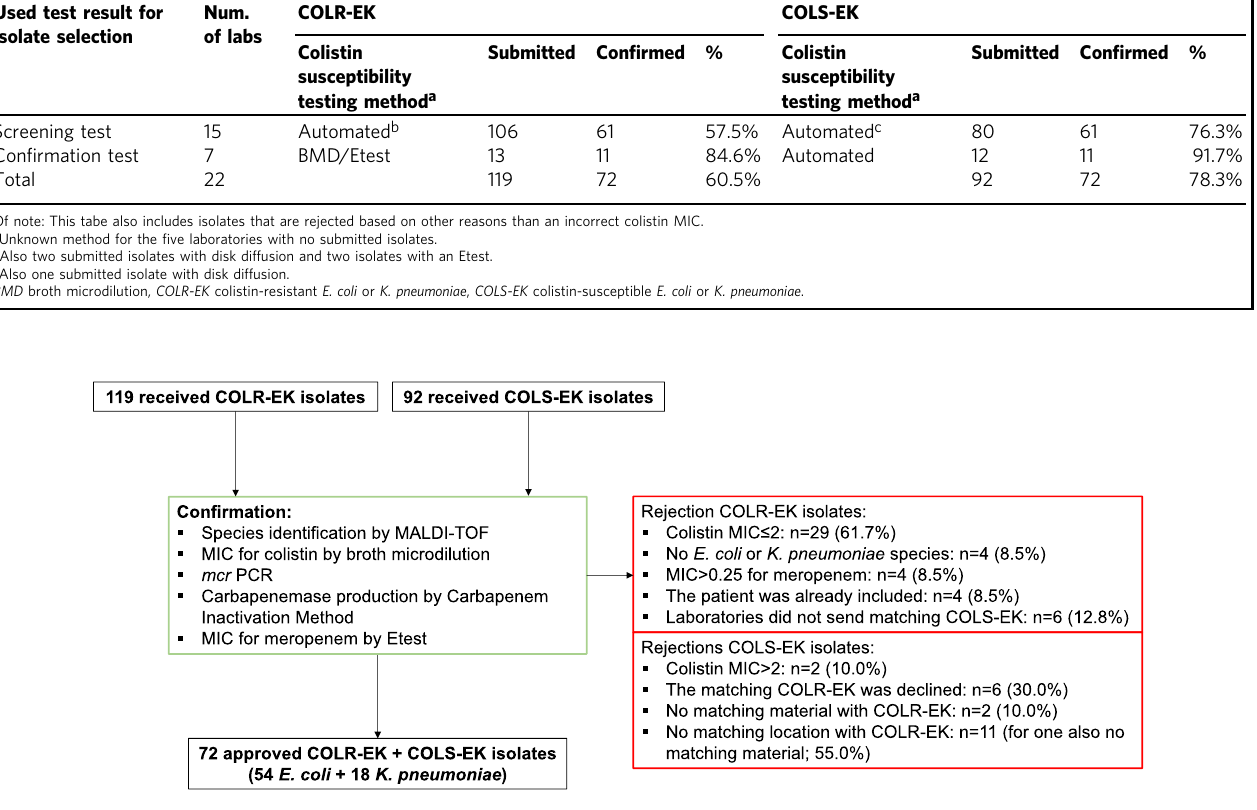
Fig. 1 Flow chart of received colistin-resistant and colistin-susceptible isolates. Methods used to decide which isolates met study inclusion criteria are denoted in the green square. Reasons for rejection of isolates for inclusion in the study are denoted in the red squares. COLR-EK: colistin-resistant E. coli or K. pneumoniae , COLS-EK: colistin-susceptible E. coli or K. pneumoniae , MALDI-TOF: matrix-assisted laser desorption/ionisation time-of- fl ight analyser, MIC: minimum inhibitory concentration, PCR: polymerase chain